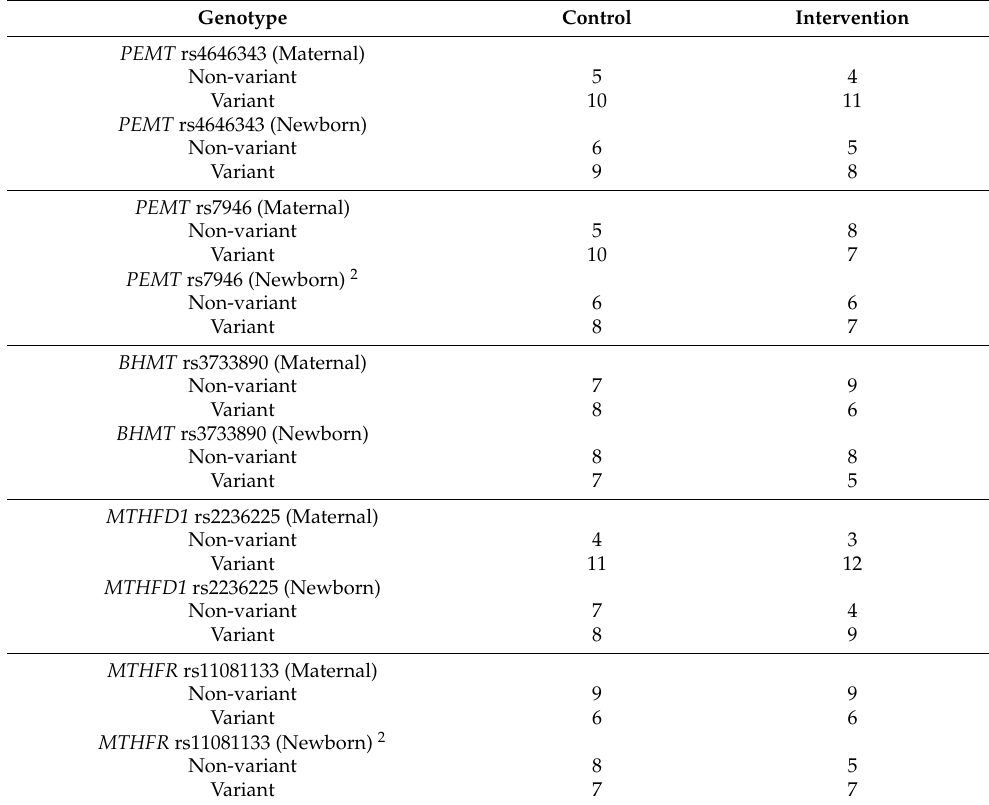
Table 1. Frequency of maternal ( n = 30) and newborn ( n = 28) genotypes by choline intervention arm 1 .